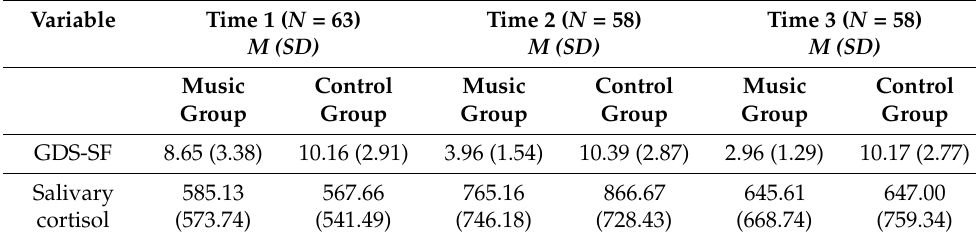
Table 2. Mean values of depression and salivary cortisol at different